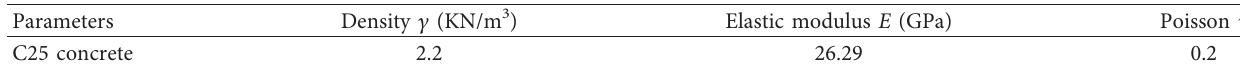
Table 2: Physical and mechanical parameters of concrete.